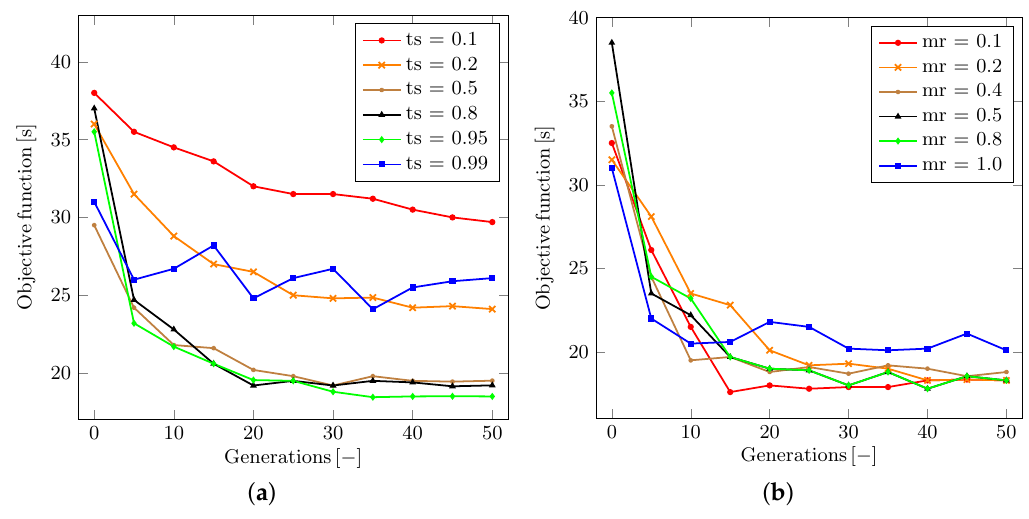
Figure 9. Optimization results for the real traffic scenario.